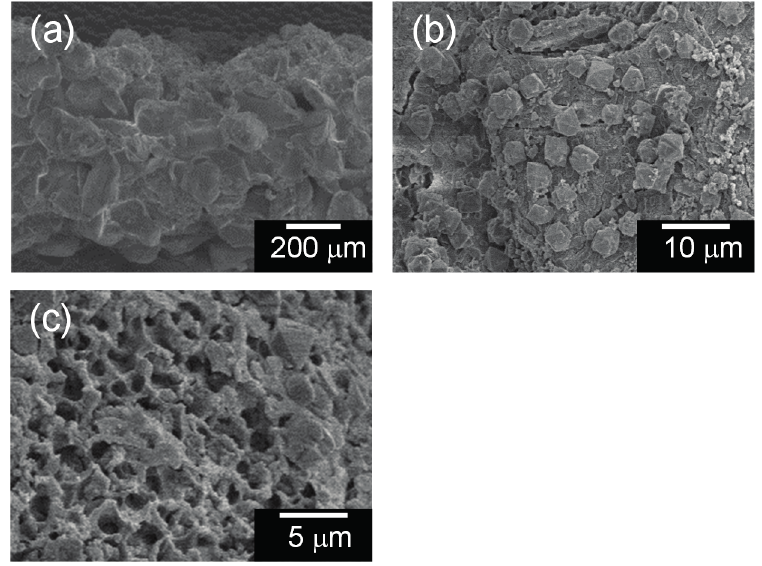
Figure 3. FE-SEM images of the zeolite-porous glass composite: ( a ) low magnification image; ( b ) precipitated zeolite particles; and ( c ) micro pores formed on the glass surface.